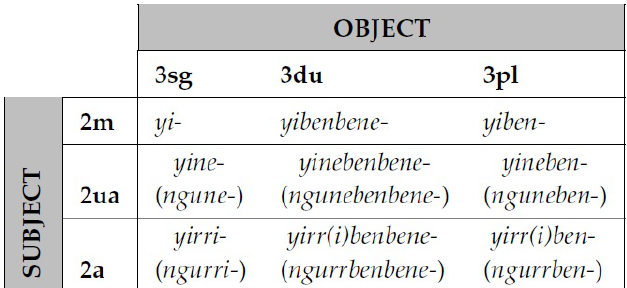
Table 5. Regularised second person subject paradigm.